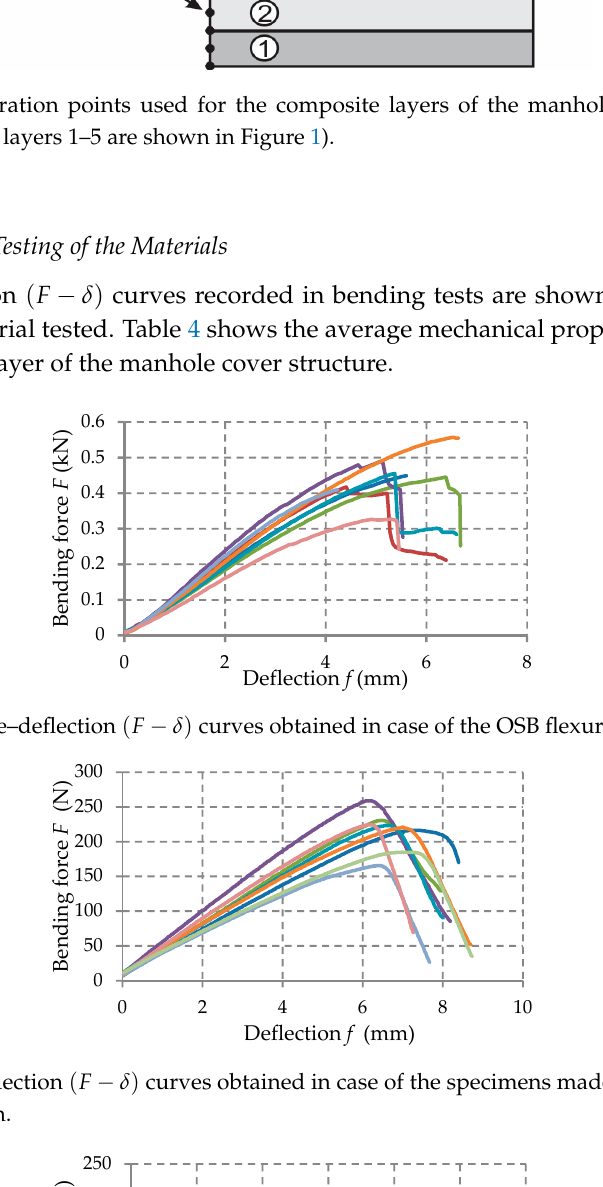
Figure 9. The integration points used for the composite layers of the manhole cover (materials corresponding to the layers 1–5 are shown in Figure 1).